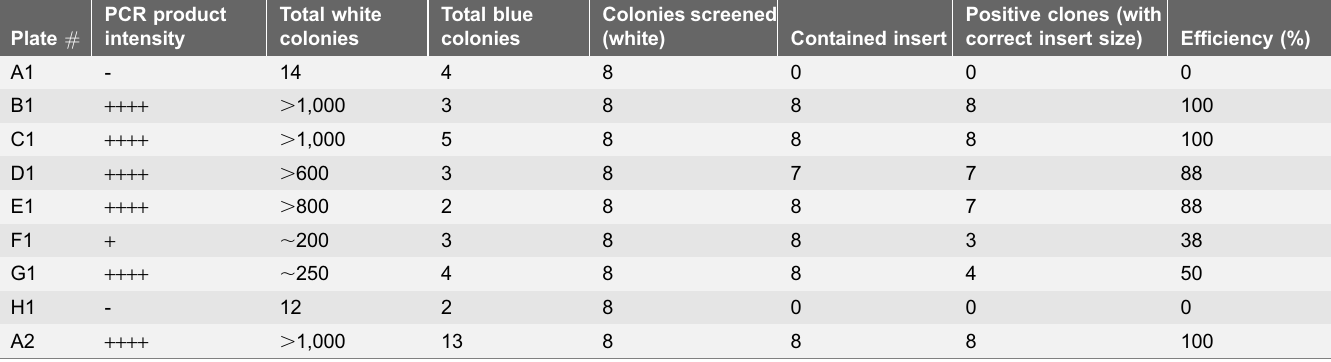
Table 2. PCR screening of colonies from nine Hot Fusion transformation plates. PCR product Total white Total blue Colonies screened Plate # intensity colonies colonies (white) Contained insert